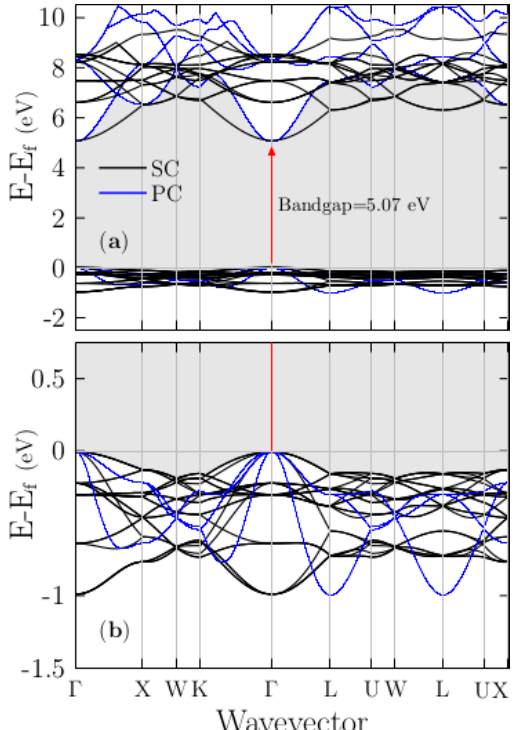
Figure 2. The upper panel ( a ) shows the band structure of the primitive cell (PC) for KCl (blue lines) and the folded band structure of the supercell (SC) of pristine K 8 Cl 8 (black lines) along with the same high-symmetry directions of the Brillouin zone (BZ) of the PC. The lower panel ( b ) shows a zoomed view in the region − 1.5 to 0.75 eV. The shortest direct Kohn–Sham bandgap indicated by the red arrow is 5.07 eV at the Γ point. The blue lines correspond to the PC band structure, and the black lines correspond to the SC band structure. Figure S4 of the supplementary information, we show the band structure with applied scissors